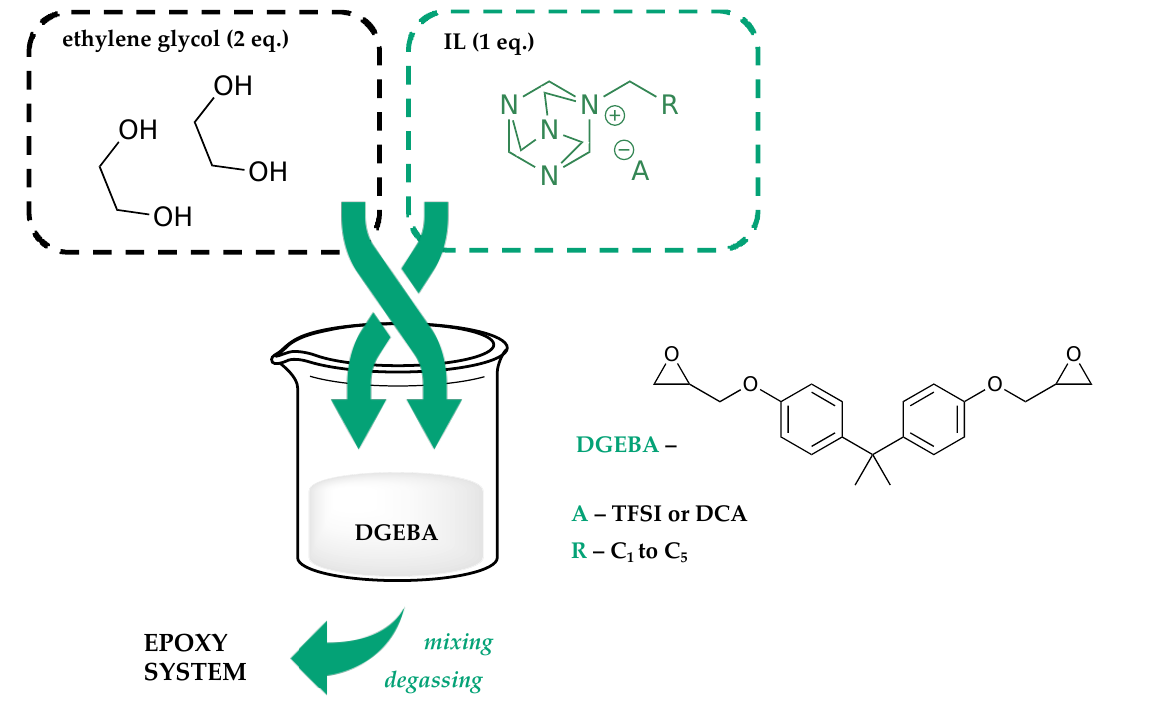
Figure 3. Scheme of the process of preparing resin systems with ionic liquids.